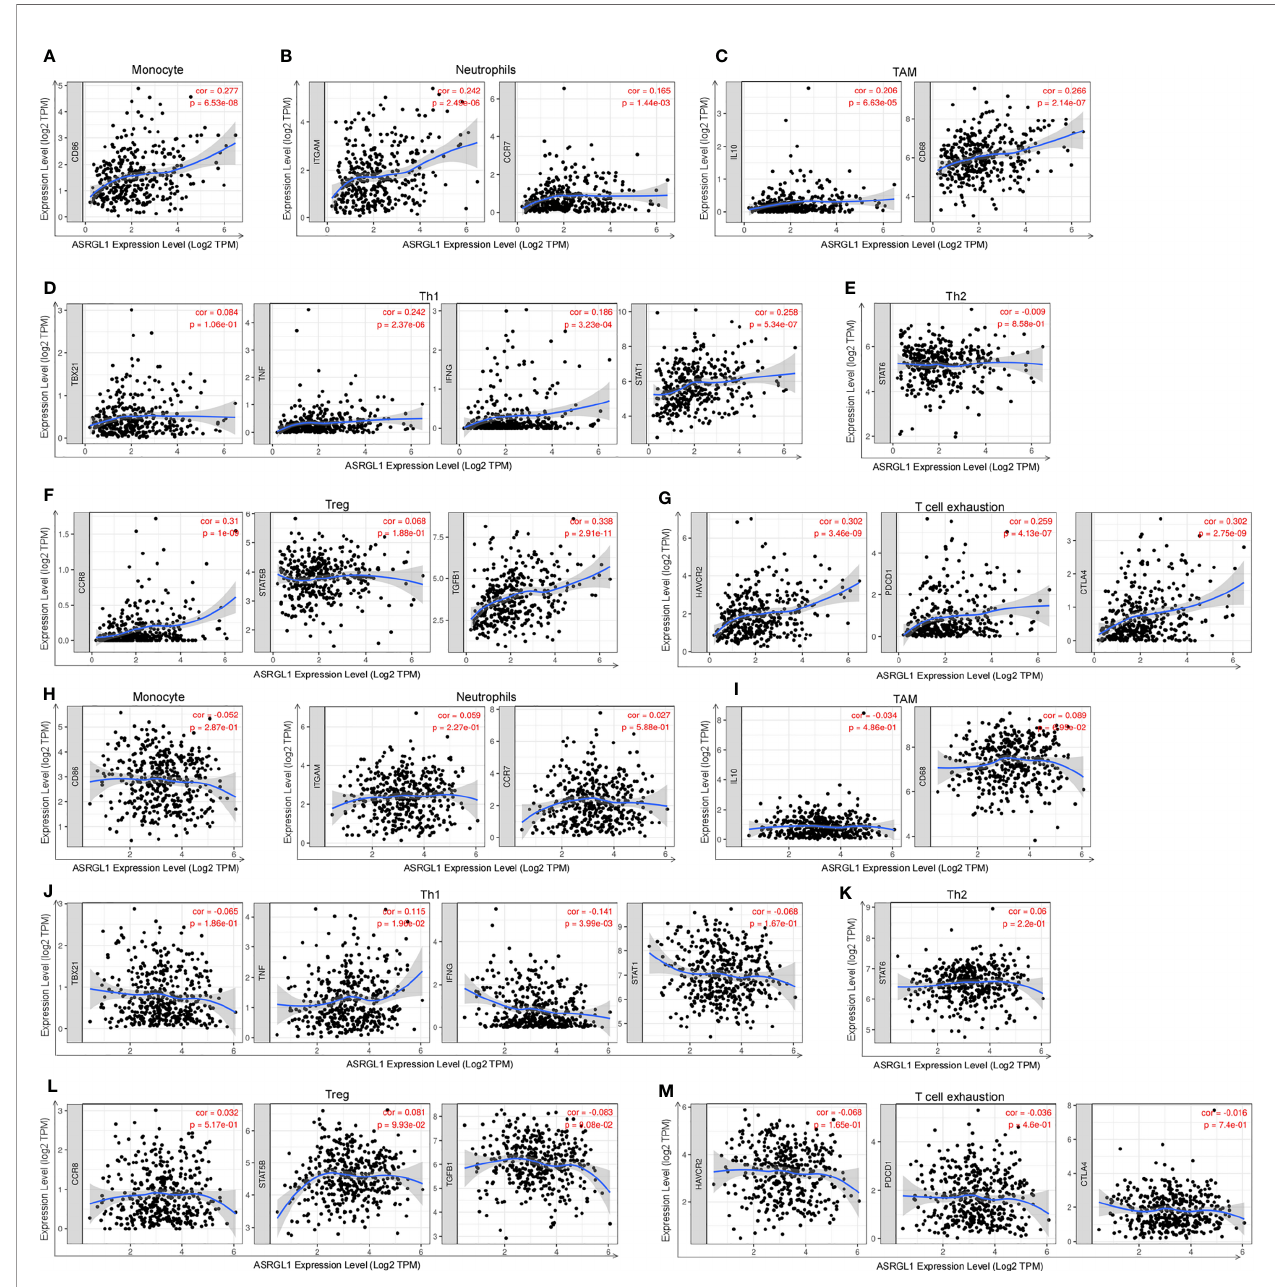
FIGURE 8 | Correlation analysis of ASRGL1 expression and the expression of marker genes of in fi ltrating immune cells in HCC (A – G) and STAD (H – M) using the TIMER database. (A – G) Scatter plots showing a high correlation between the mRNA expression of ASRGL1 and the gene markers of (A) monocytes (CD86); (B) neutrophils (ITGAM and CCR7); (C) TAMs (IL-10 and CD68); (D) Th1 cells (TNF, IFNG, and STAT1); (F) Tregs (CCR8, STAT5B, and TGFB1); and (G) exhausted T cells (HAVCR2, PDCD1, and CTLA4) in HCC samples (n = 371). (H – N) Scatter plots showing no signi fi cant correlation between the mRNA expression of ASRGL1 and the gene markers of (H) monocytes (CD86); (I) neutrophils (ITGAM and CCR7); (J) TAMs (IL-10 and CD68); (K) Th1 cells (TBX21, IFNG and STAT1); (L) Th2 cells (STAT6); (M) Tregs (CCR8, STAT5B, and TGFB1); and (N) exhausted T cells (HAVCR2, PDCD1, and CTLA4) in STAD (n =